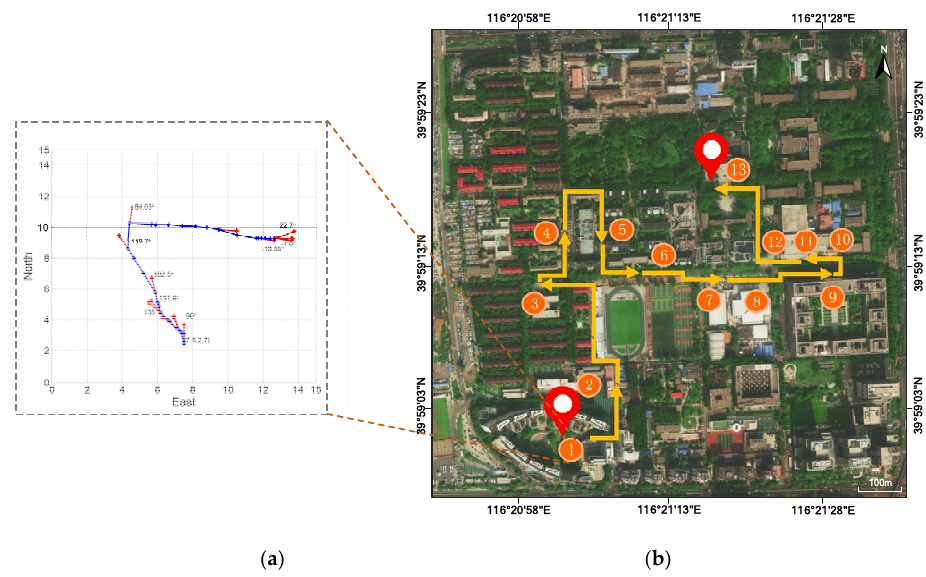
Figure 16. The FPV based pedestrian navigation result. ( a ) shows the movement estimation and tracking result; ( b ) plots the scene recognition result with a route estimation. Orange circles represent the identified scene position and sort by time, while yellow arrows represent estimated routes.